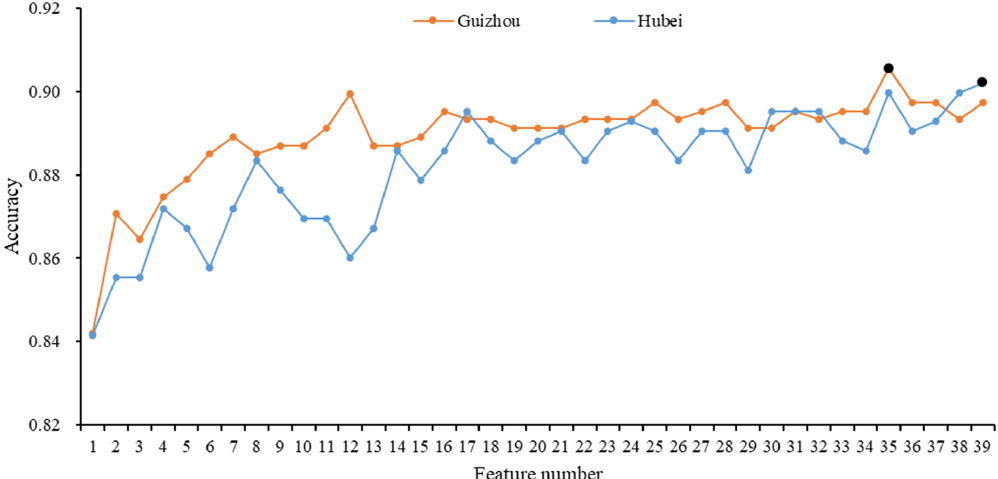
Figure 13. OA for using different feature numbers in Guizhou and Hubei. The feature addition order along the horizontal axis is identical to the feature importance ranking of the province. The maximum value of accuracy is marked in